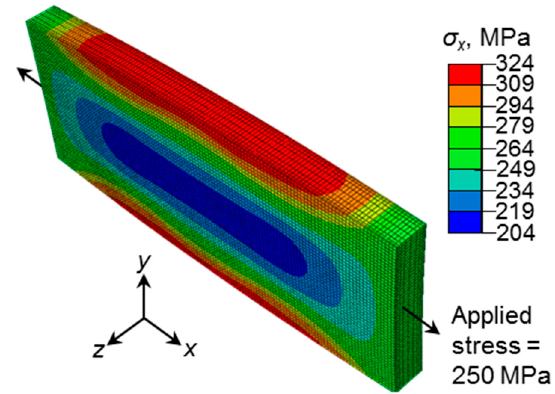
Figure 2. Distribution of x direction stresses ( σ x ) from a finite element (FE) analysis of the flat specimen gauge region at an applied stress of 250 MPa.